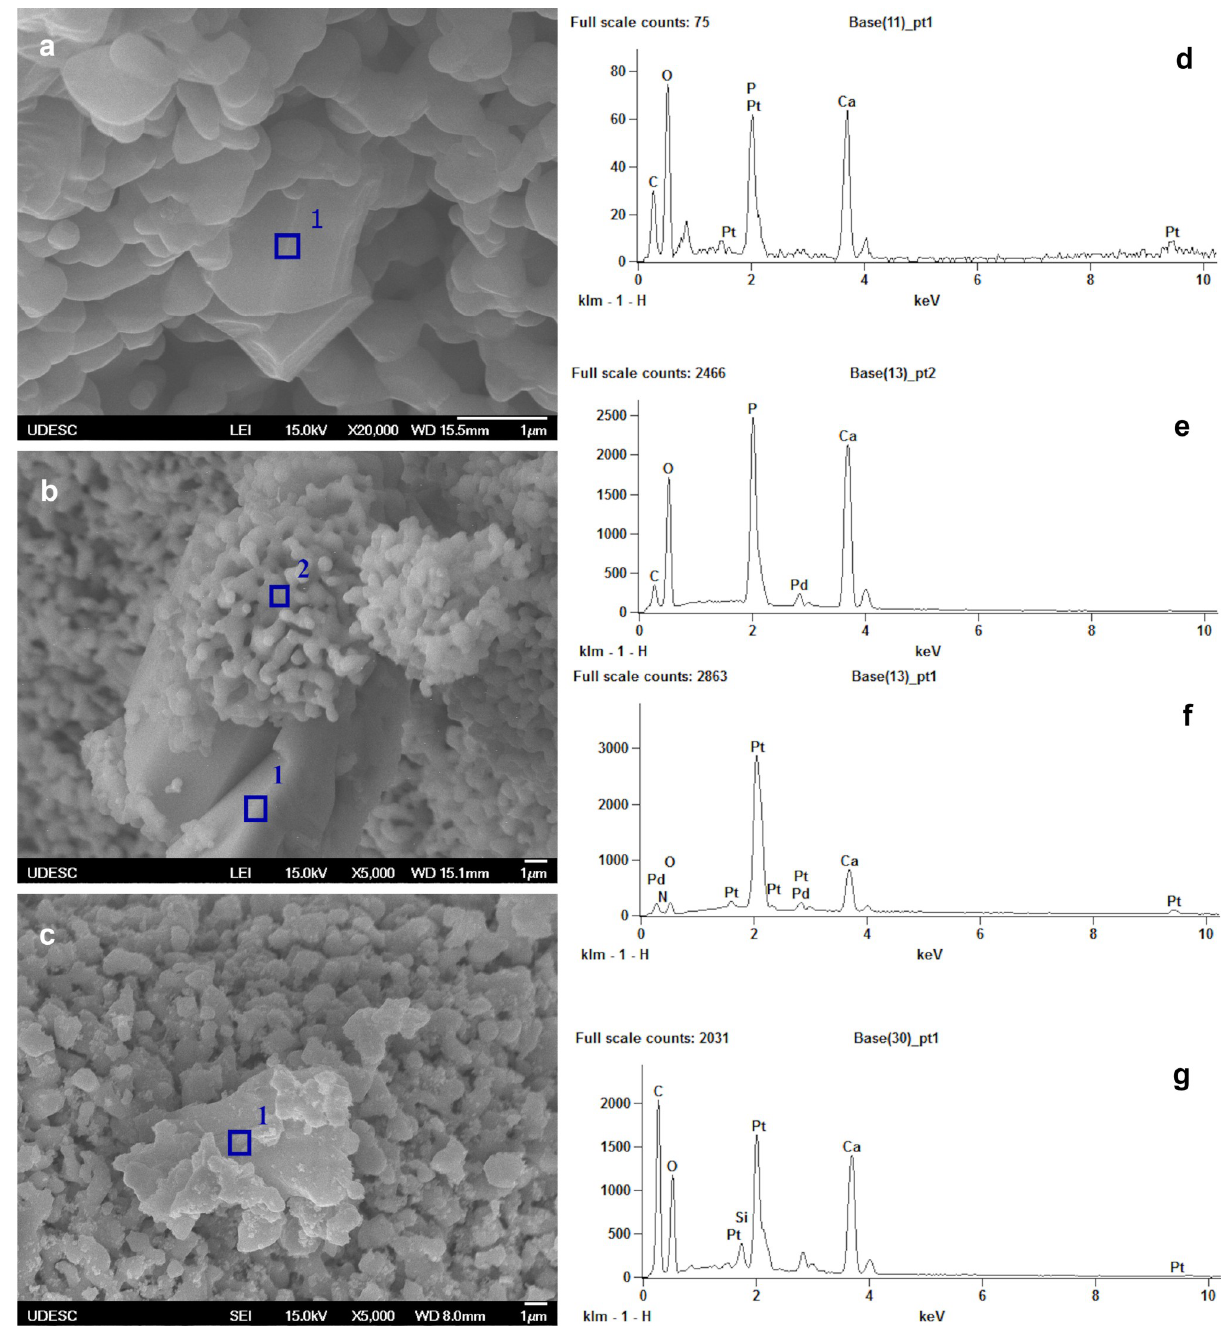
Fig 3. Morphology and composition of carboplatin precipitates on the calcium phosphate surface. Scanning electron microscopy analysis of the biomaterials-carboplatin loading: (a) well-defined micrometric carboplatin precipitated in HA-carboplatin 60 mg/g surface; (b) carboplatin precipitate and superposed calcium phosphate biomaterial in BCP-carboplatin 50 mg/g; (c) not well-defined boundary of carboplatin in β -TCP/SiO 2 nanocomposite 70 mg/g; energy dispersive spectroscopy (EDS) analysis detected peaks of marked regions: (d) the EDS analysis of point 1 in HA- carboplatin; (e) the EDS analysis of point 2 and (f) of point 1 in BCP-carboplatin; (g) the EDS analysis of the β -TCP/SiO 2